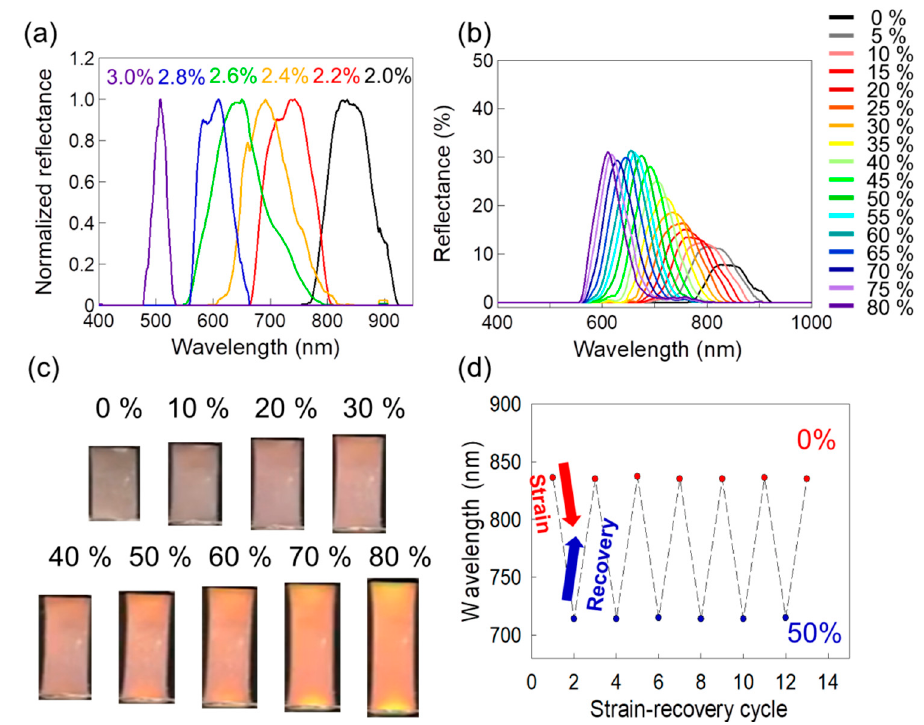
Figure 4. ( a ) Reflectance spectra of N* LC ( x ) elastomers prepared with different ISBCD concentrations. ( b ) Reflectance spectra of the N* LC (2.0) elastomer as a function of applied tensile strain (0–80%). ( c ) Photographs of the N* LC (2.0) elastomer under applied tensile strains of 0–80%. ( d ) Mechano-optical stability of the N* LC (2.0) elastomer film during compressive/tensile strain cycles from 0% to 50%.